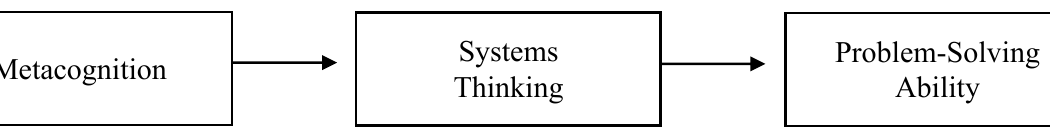
Figure 2. Output diagram of relationships between metacognition, systems thinking, and problem-solving ability.